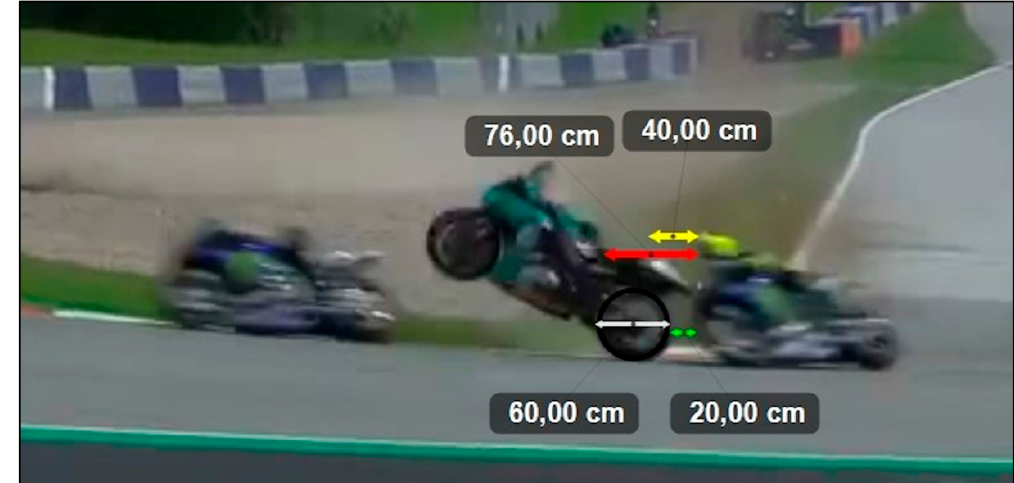
Figure 10. The frame capturing the exact instant when Morbidelli’s bike crossed Rossi’s path. Kinovea was used to measure the distances based on the measurement of the rear wheel of Morbidelli’s bike. Specifically, the white arrows indicate the 60-cm diameter of Morbidelli’s rear wheel (black circle); the green arrows represent the exact distance between Rossi’s front wheel and Morbidelli’s rear wheel; the yellow and red arrows indicate the distance that Rossi’s bike would have covered if he had slowed down according to scenario 1 (about 40 cm) and scenario 2 (about 76 cm), respectively.